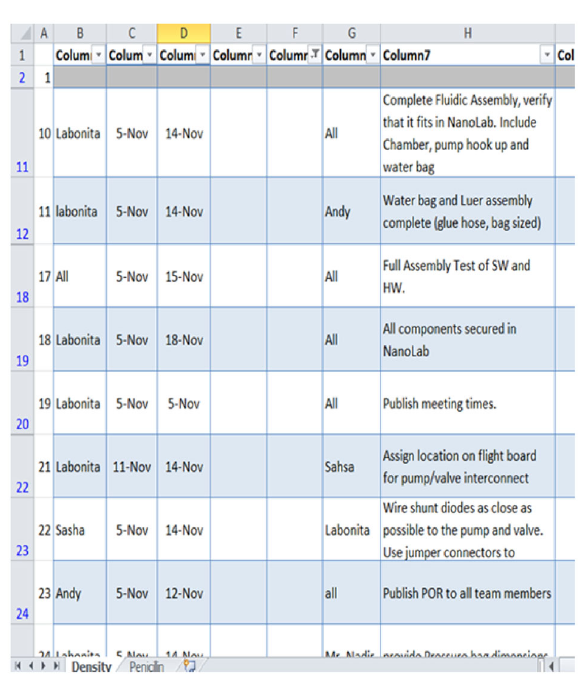
Fig. 8 Example action item list maintained by fl uidic density co-